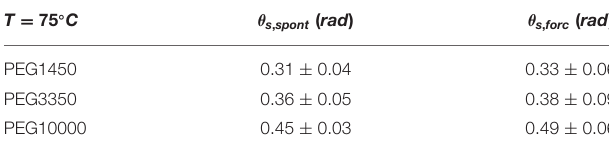
TABLE 2 | Comparison of static contact angles obtained in spontaneous and forced wetting modes with PEGs at T = 75 ◦ C. T = 75 ◦